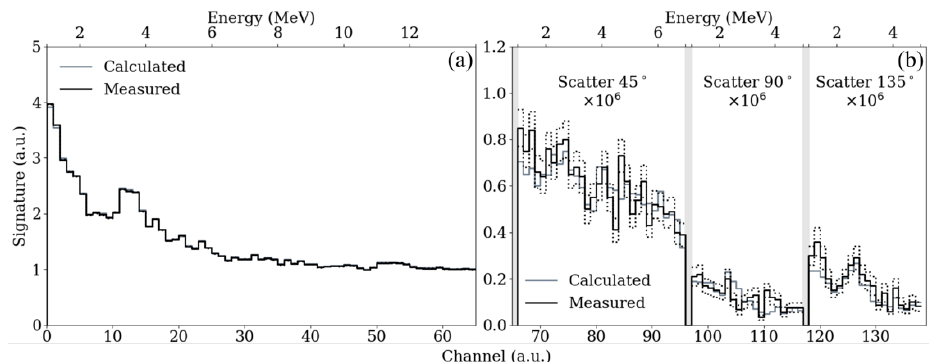
Fig. 5. Simulated signatures for (a) transmitted (0 ° ) neutrons, and (b) scattered neutrons (45 ° -135 ° ), shown together with the refolded signatures obtained using the MAXED package. Statistical uncertainties on the simulated signatures are indicated with the dotted lines.